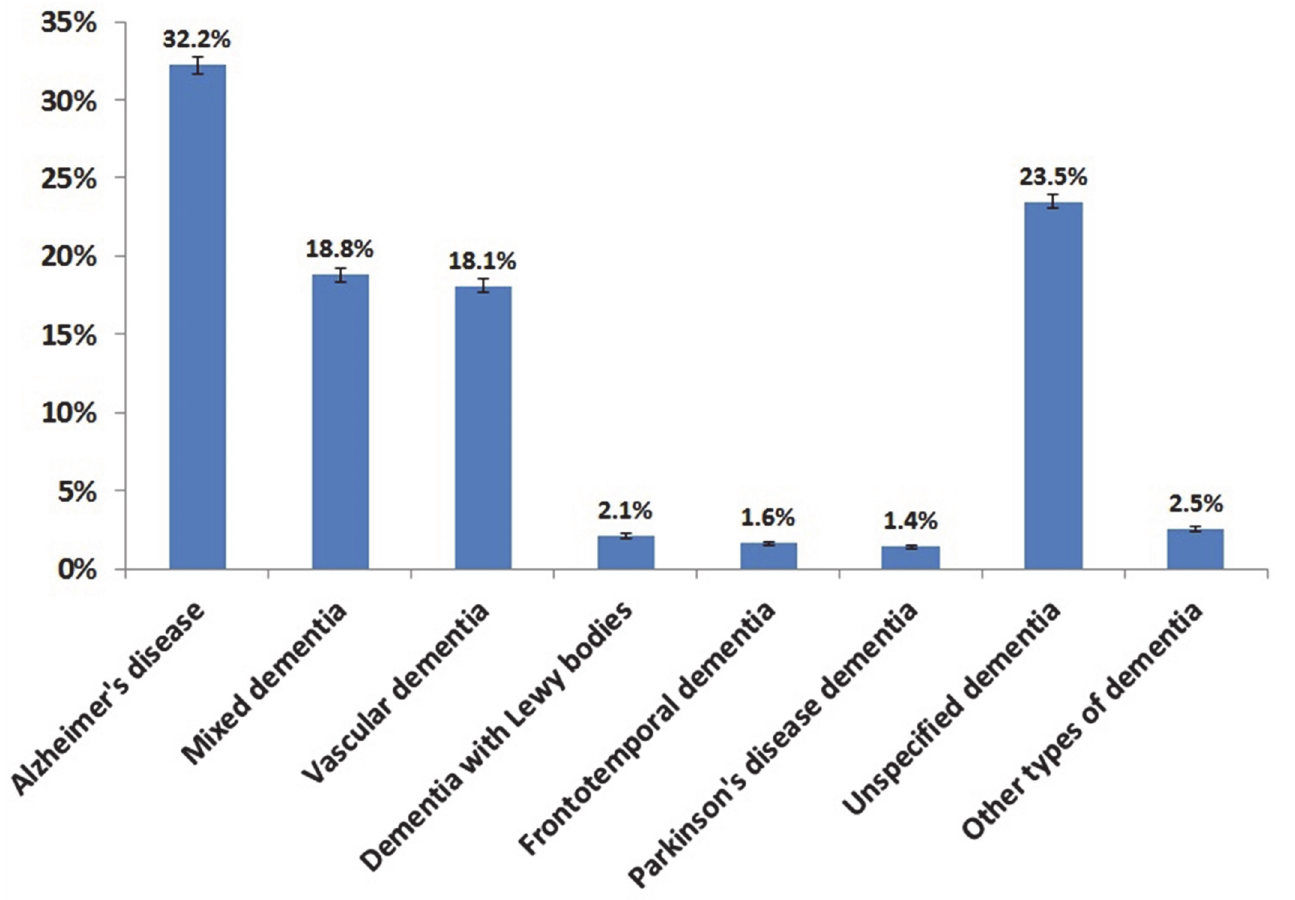
Fig 2. Frequency of different types of dementia in the whole population registered in SveDem during 2007 – 2012 (n = 28722).